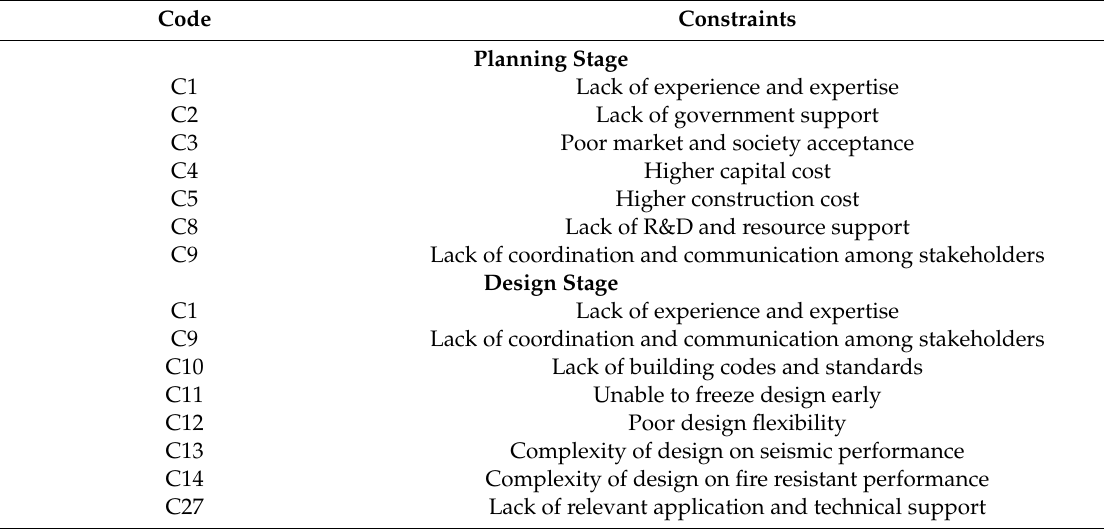
Table 6. Critical constraints in five